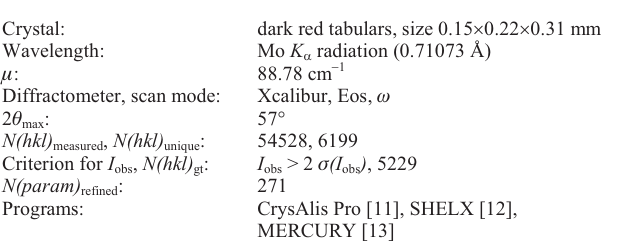
Table 1. Data collection and